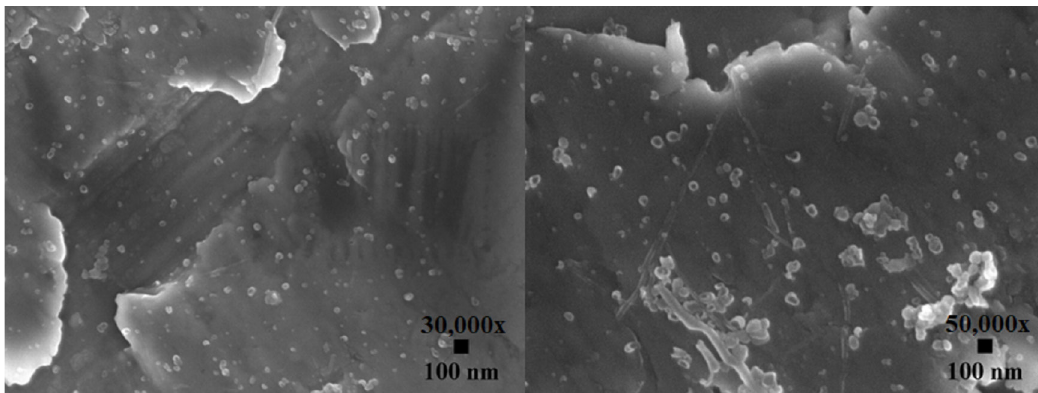
Figure 2. Nanopores over anodized titanium surface with HCl at 11V with a 3M concentration in 10 min.